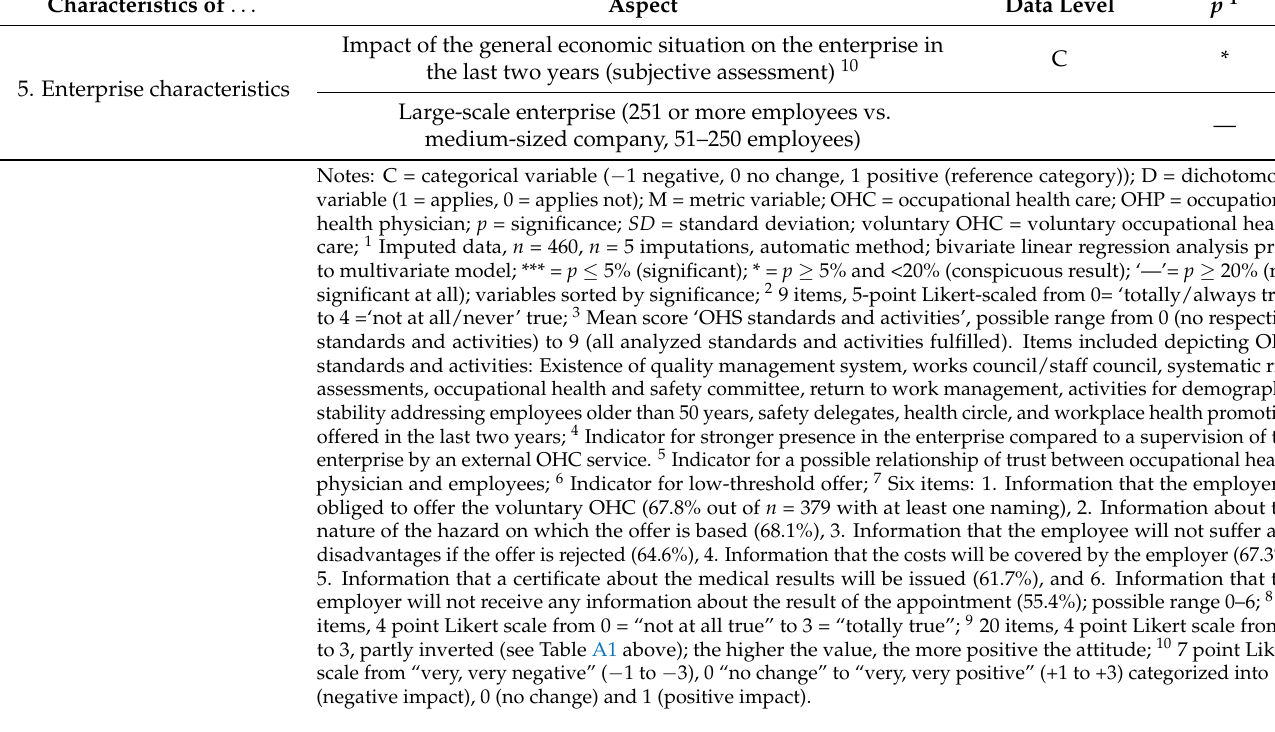
Table A4. Characteristics of the described